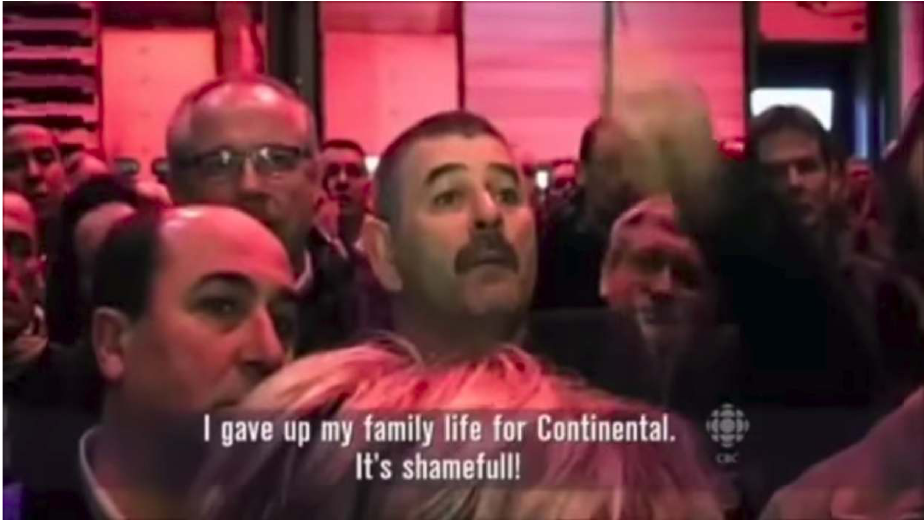
Source: Global Financial Meltdown by Terrence McKenna (screen